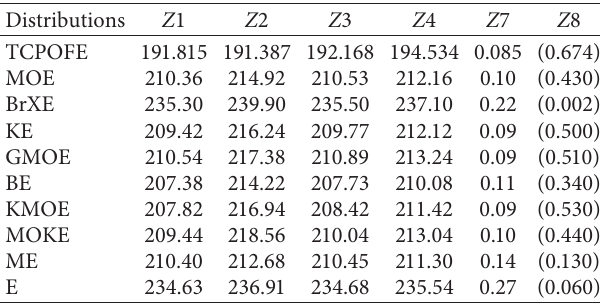
Table 4: Some IC for dataset I.